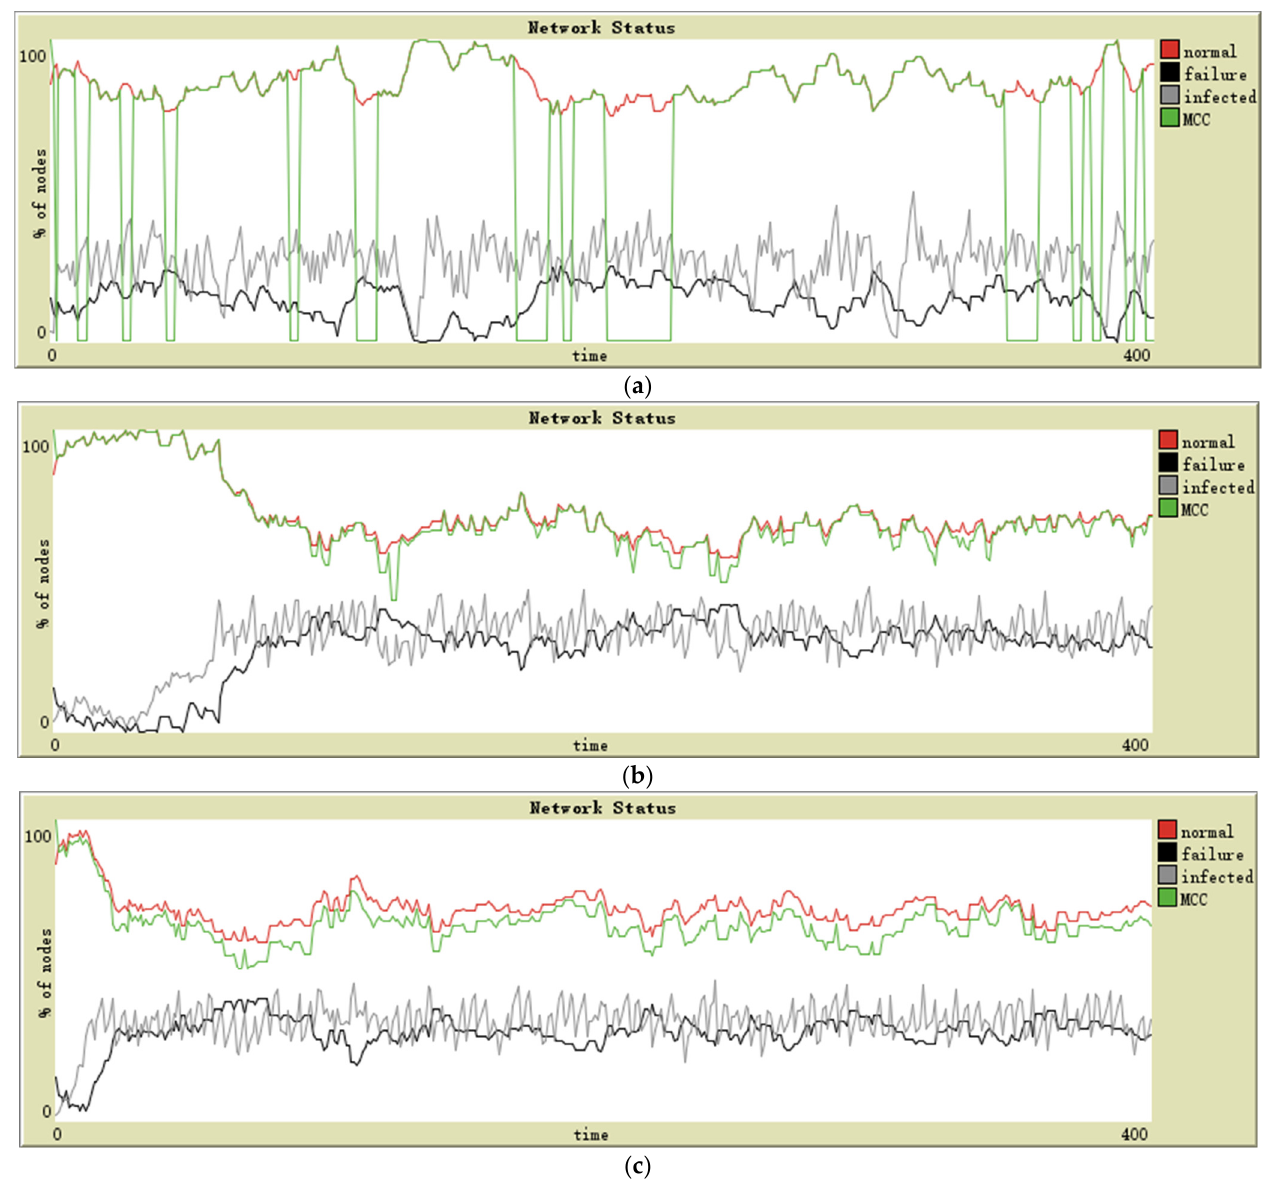
Figure 3. Simulation on military surveillance application in ( a ) star topology, ( b ) lattice-2d topology, and ( c ) random topology.